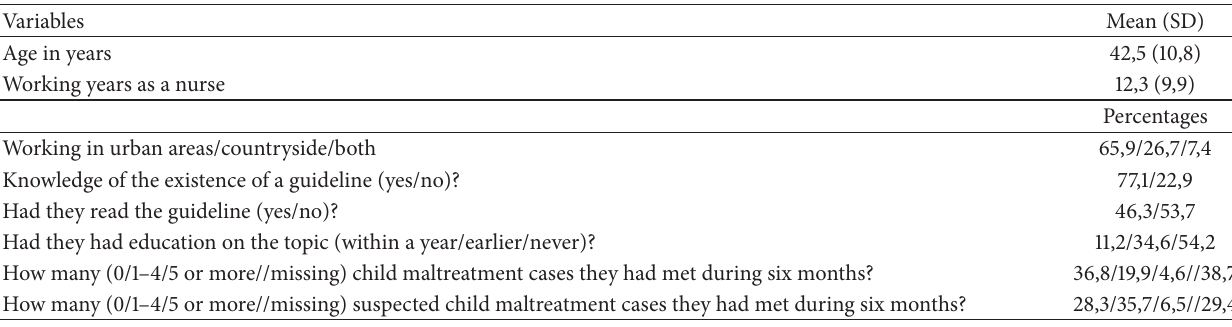
Table 1: Background information concerning the participants ( 𝑁 = 367 ).